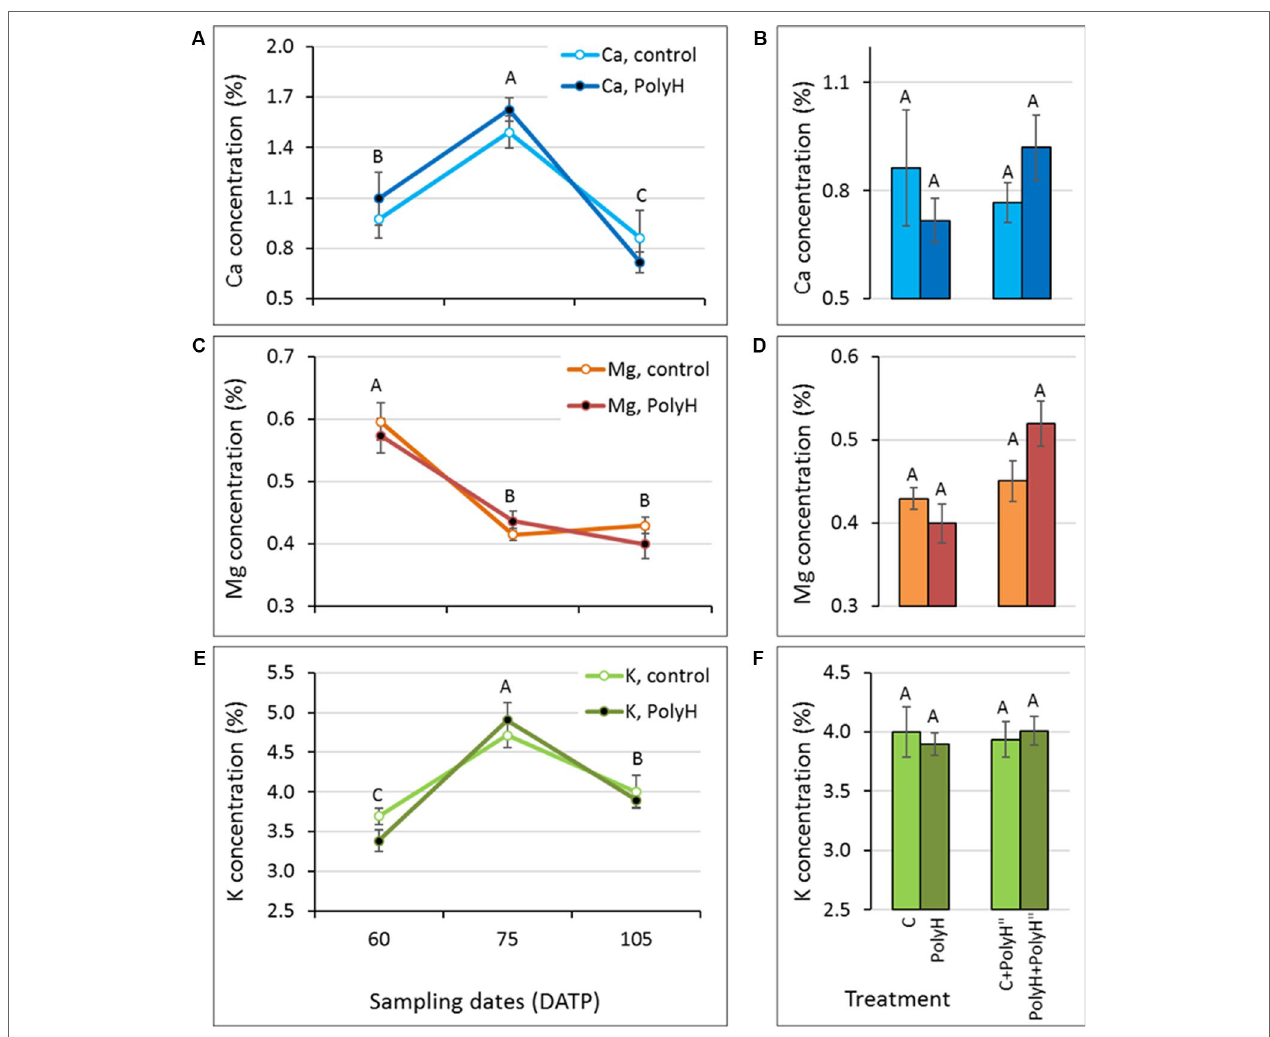
FIgURE 6 | Mineral elements concentration in peels of early- to late-bulking Vivaldi tubers following polyhalite fertilization (experiment 3). Sample labeling and charts are as described in legend of Figure 5 , except: (a , C , E) tuber peel was collected at 60, 75, and 105 DATP, and (B , D , F) late in-season application of polyhalite (PolyH") was performed at 95 DATP and samples were collected at 105 DATP. Statistical analysis was performed as described for Figure 5 .